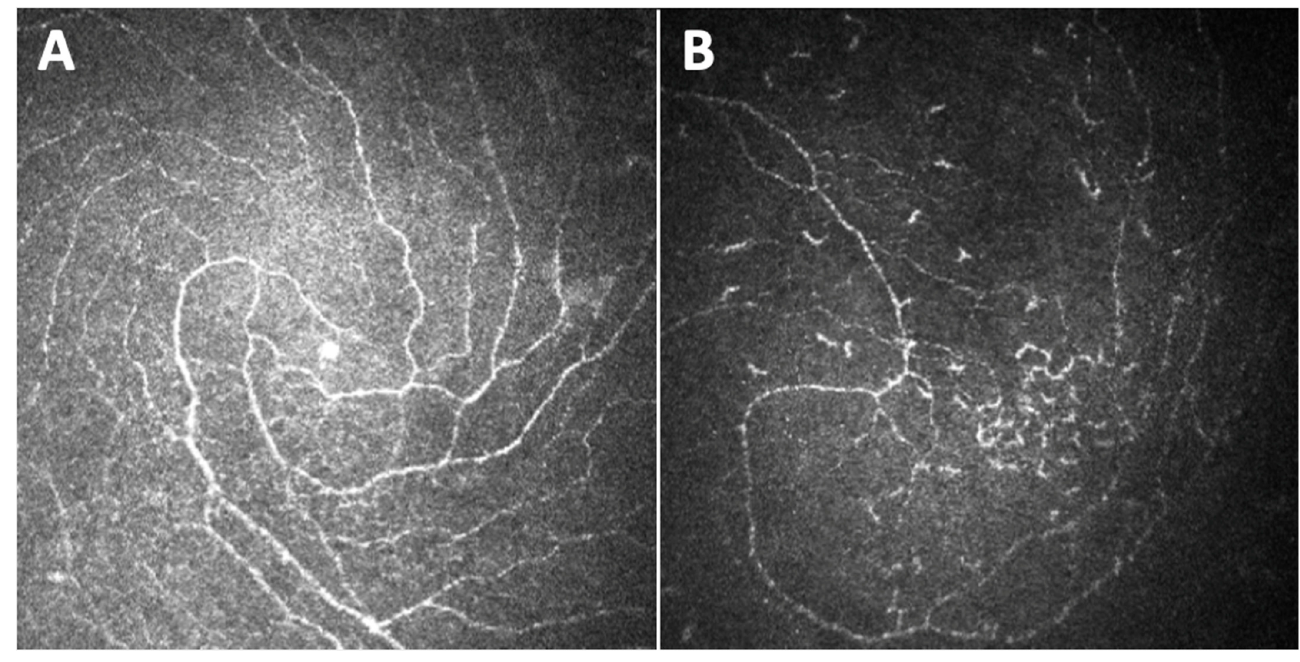
Figure 4. Images of the inferior whorl captured with Heidelberg Retina Tomograph III Rostock Corneal Module (Heidelberg, Germany) of a healthy subject ( A ) and a diabetic subject with diabetic peripheral neuropathy ( B ), showing an evident depletion of fibers in the diabetic neuropathic pa- tient.